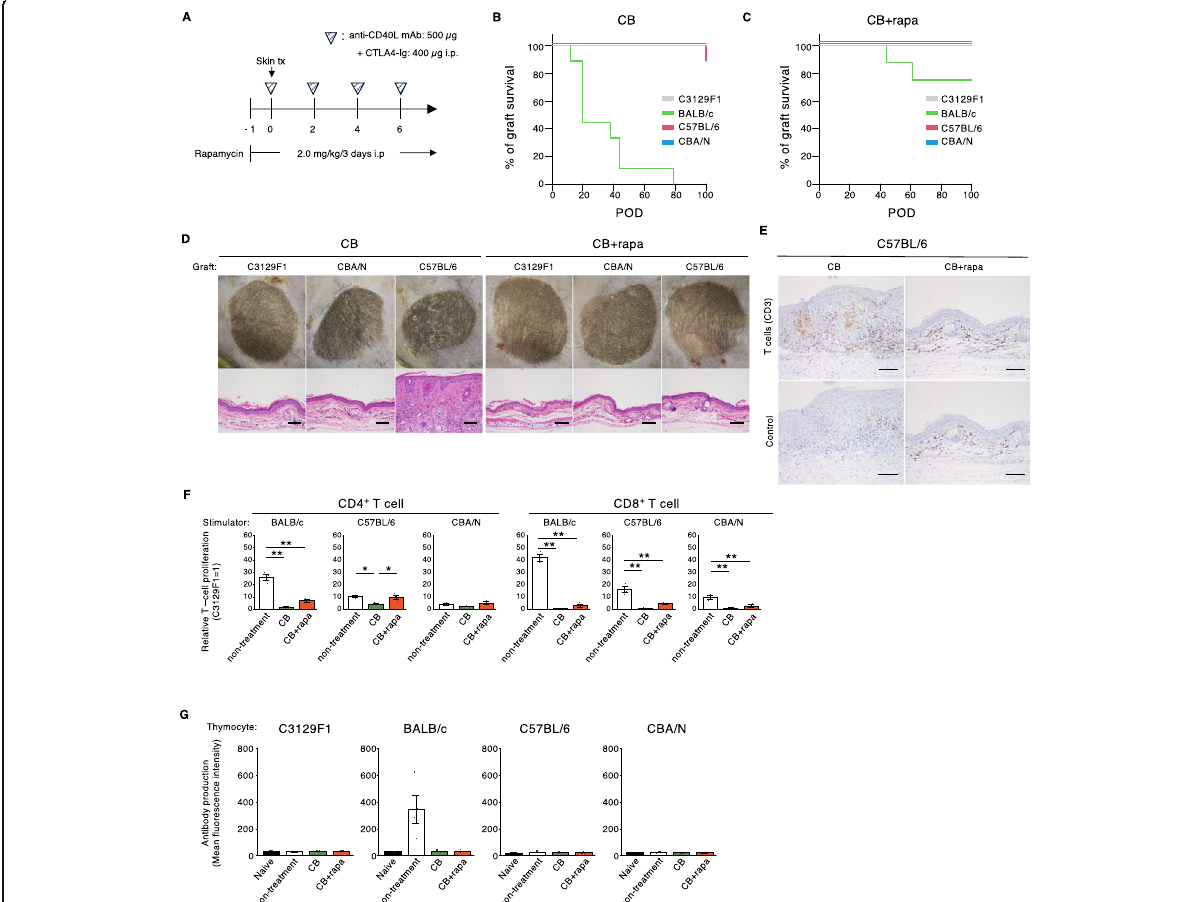
Fig. 2 Blockade of leukocyte costimulatory molecules permits long-term engraftment of mouse skin grafts from MHC-matched allogeneic donors. ( A ) CB-based immunoregulation protocol. Immunosuppression was performed by using a protocol of administrating a combination of anti-CD40L mAb and CTLA4-Ig daily (CB) with or without rapamycin on every 3 days from POD 1 (CB + rapa). ( B ) Skin graft survival under immunosuppression with CB ( n = 9, C3129F1; n = 9, BALB/c; n = 9, C57BL/6; n = 9, CBA/N). ( C ) Skin graft survival under immunosuppression with CB + rapa ( n = 9, C3129F1; n = 8, BALB/c; n = 9, C57BL/6; n = 9, CBA/N). ( D ) Macroscopic observation (upper panels) and hematoxylin and eosin stained section (lower panels) of autologous (C3129F1), CBA/N, and C57BL/6 skin grafts on day 100. Scale bars: 100 μ m. ( E ) Immunohistochemical staining for CD3 of C57BL/6 skin grafts harvested from CB or CB + rapa treated groups on 100 days post-transplantation. Upper and lower panels represent CD3 specific staining and isotype control stained section, respectively. Scale bars: 100 μ m. ( F ) Recipient T cell response in MHC-matched but minor antigen-mismatched skin transplantation. The T cell proliferation rates in each treatment group were normalized to that of C3129F1 mice stimulated with autologous irradiated splenocytes. Error bars indicate standard error of technical triplicates. Similar results were obtained in two independent experiments. * p < 0.05, ** p < 0.01 (Tukey ’ s HSD test). ( G ) De novo anti-donor antibody production in the recipients. Error bars indicate standard error of biological replicates ( n = 8, naive; n = 4, non-treatment; n = 9, CB; n = 9, CB + rapa). tx, transplantation; mAb, monoclonal antibody; CB, co-stimulatory molecule blocking; rapa, rapamycin; POD, post-operative